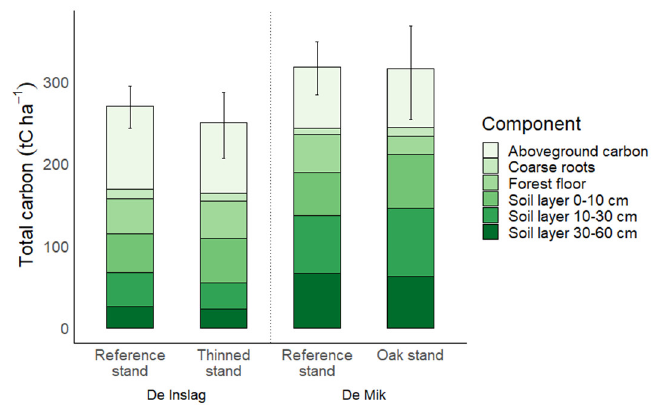
Figure 4. Total ecosystem C storage (tC ha − 1 ; mean and SD) for the investigated stands, with a separation between components. Note that (i) the aboveground C consists of the aboveground biomass and the woody debris, and (ii) for each soil layer, the C stock of the mineral soil and the fine and medium roots were aggregated.